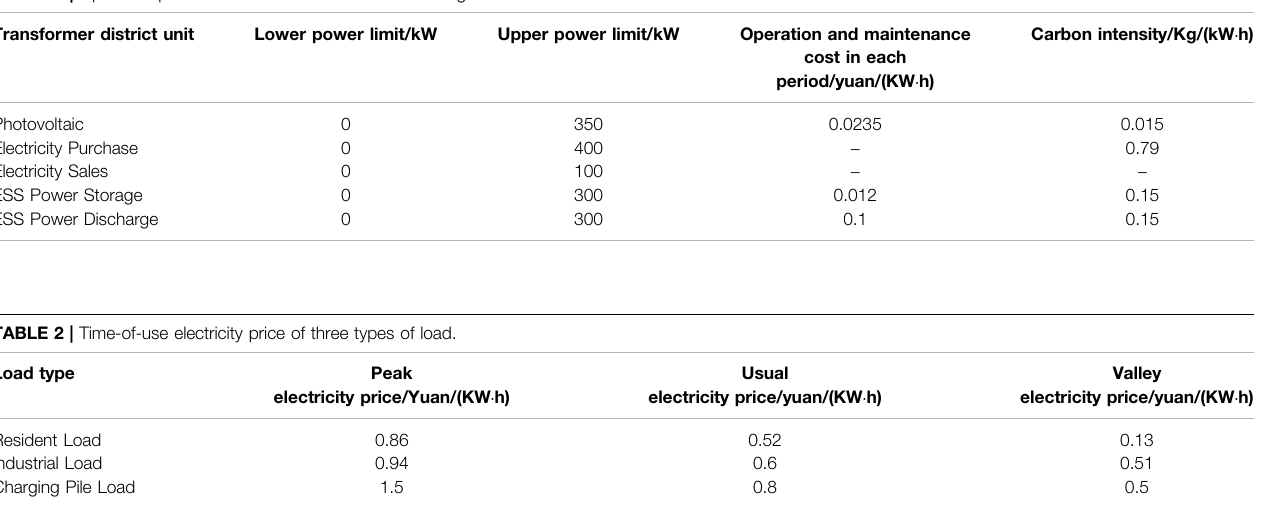
TABLE 1 | Operation parameters of each unit in the low-voltage transformer district.